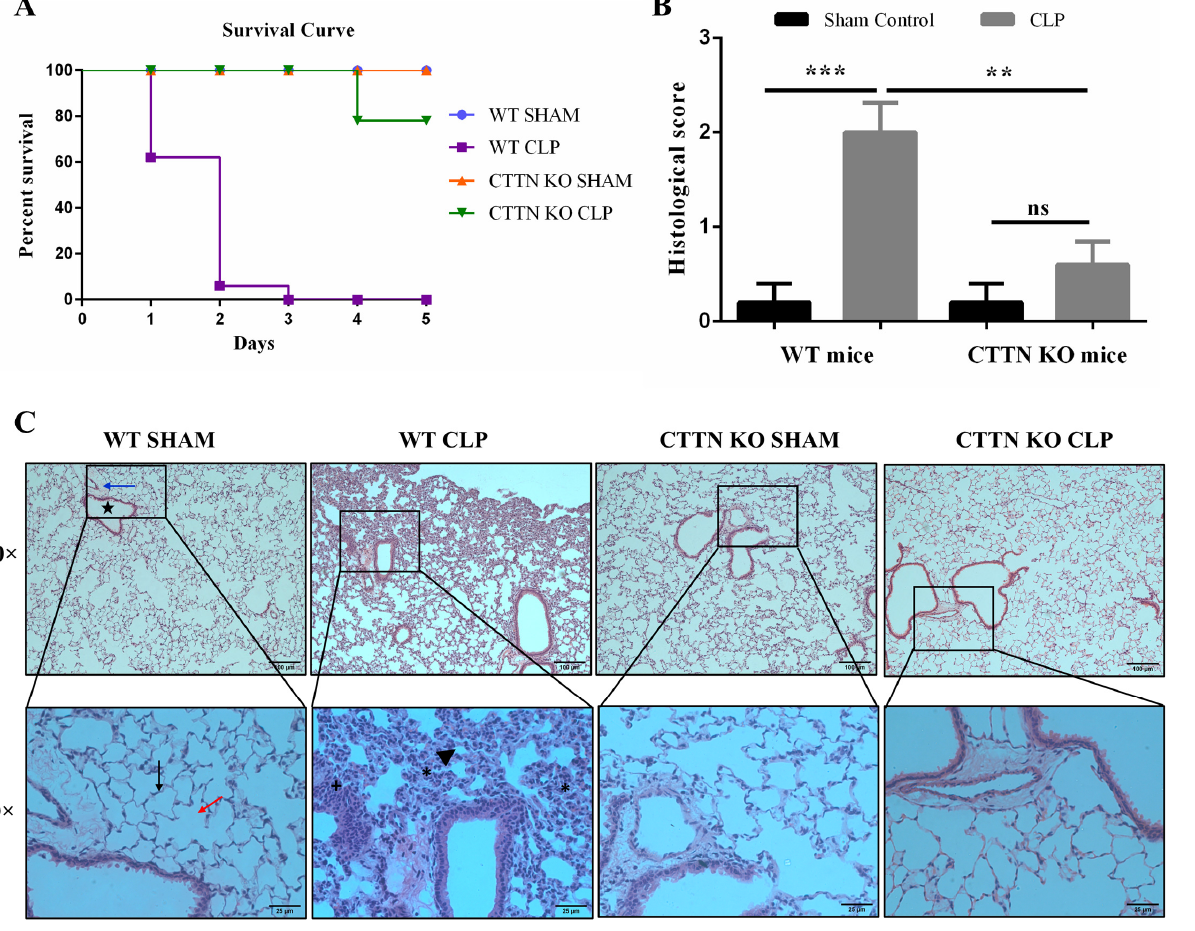
Figure 1. Cortactin gene ablation improves survival and protects against sepsis-induced lung tissue damage. ( A ) Five-day survival curve of mice subjected to CLP or Sham surgeries. Animals monitored for 5 days for survival. n = 10 for WT/CTTN KO Sham, n = 10–12 for WT/CTTN KO CLP. ( B ) The histological score of inflammatory changes in the lung tissue using the following parameters: alveoli space closing and collapse, alveolar wall thickening and fibrosis, oedema, haemorrhage, and leukocyte infiltration. 0: absence of inflammation, 1: low inflammation, 2: moderate inflammation, 3: high inflammation. ( C ) Representative histological images of lung tissue cross-sections. Sham-operated WT and CTTN KO mice showed normal lung tissue histology characterised by a normal alveolar area (red arrow), single cell layer thick alveolar wall (black arrow), normal bronchiolar area (star), preserved blood vessels (blue arrow), absence of leukocyte infiltration, and oedema. WT CLP mice showed major signs of lung inflammation and injury seen as massive leukocyte infiltration (+), alveolar wall thickening (asterisks), and alveolar space closing and collapse (black arrowhead). Data are represented as mean ± standard error of the mean (SEM) of at least 5 animals. ** p < 0.01, *** p < 0.001, ns: non-significant. CTTN: cortactin; CLP: Cecal ligation and puncture.